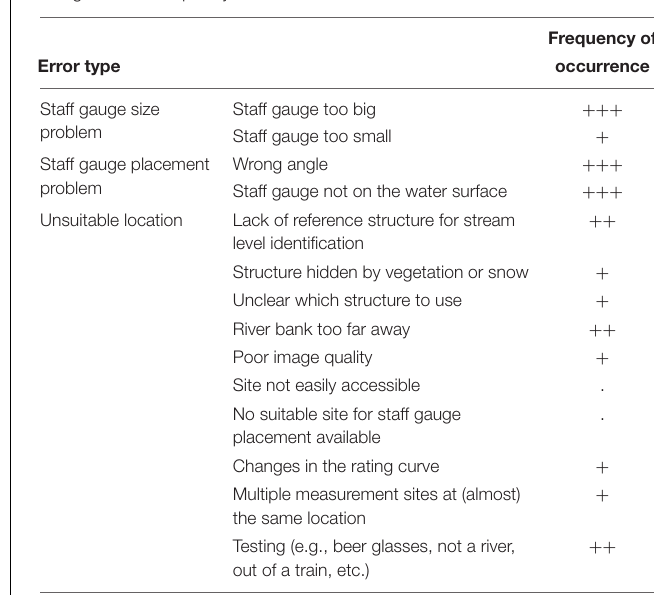
TABLE 1 | Collection of errors made by app-users grouped into broader error categories and frequency of